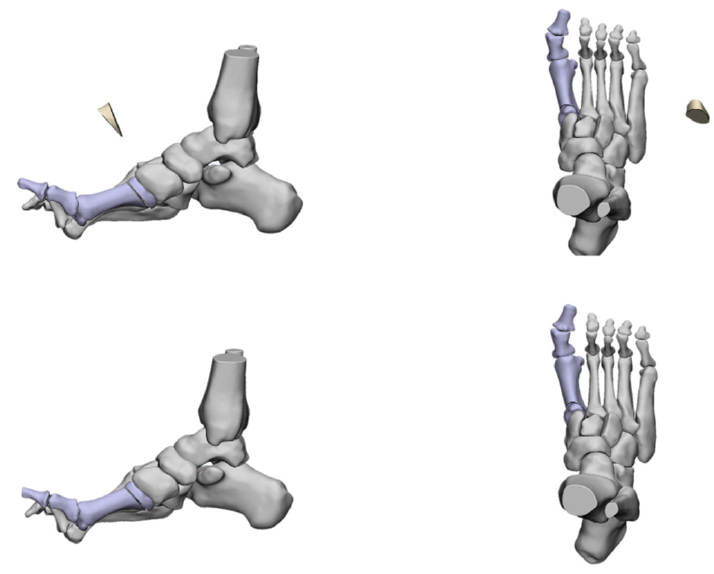
Figure 9. The dorsal closed wedge osteotomy of the first metatarsal.